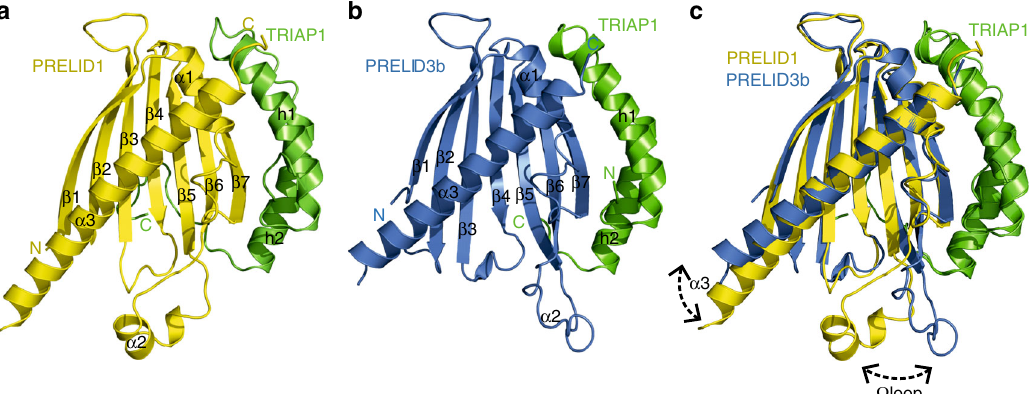
Fig. 1 Crystal structures of PRELID1 1 – 173 and PRELID3b in complex with TRIAP1. a Ribbon cartoon of PRELID1 1 – 173 (yellow) in complex with TRIAP1 (green) generated in pymol graphics package. Secondary structure elements are shown in black, and indicated as; α = α -helix, β = β -strand for PRELID1 1 – 173 and h = helix for TRIAP1, and numbered accordingly from N-terminus to the C-terminus. N and C indicate termini that are coloured according to protein chain. b Ribbon cartoon of PRELID3b (blue) in complex with TRIAP1 (green) generated in pymol graphics package. Secondary structure elements are shown in black, and indicated as; α = α -helix, β = strand for PRELID3b and h = helix for TRIAP1 and numbered accordingly from N-terminus to the C-terminus. N and C indicate termini that coloured according to protein chain. c Comparison of PRELID1 1 – 173 -TRIAP1 (yellow-green) and PRELID3b – TRIAP1 complexes (blue- green). Smooth ribbon representation of the structural alignment of PRELID1 1 – 173 -TRIAP1 and PRELID3b – TRIAP1 complexes scoring RMSD = 1.3 Å over the backbone atoms of 223 residues. Secondary structure elements ( α = α -helix, β = β -strand) presenting differences between the two models are indicated. The position of the fl exible α 2 and C-terminal α 3 is indicated with dotted